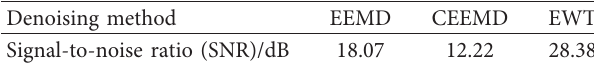
Figure 3: Comparison of denoising effects of simulated signals. Table 1: SNR comparison